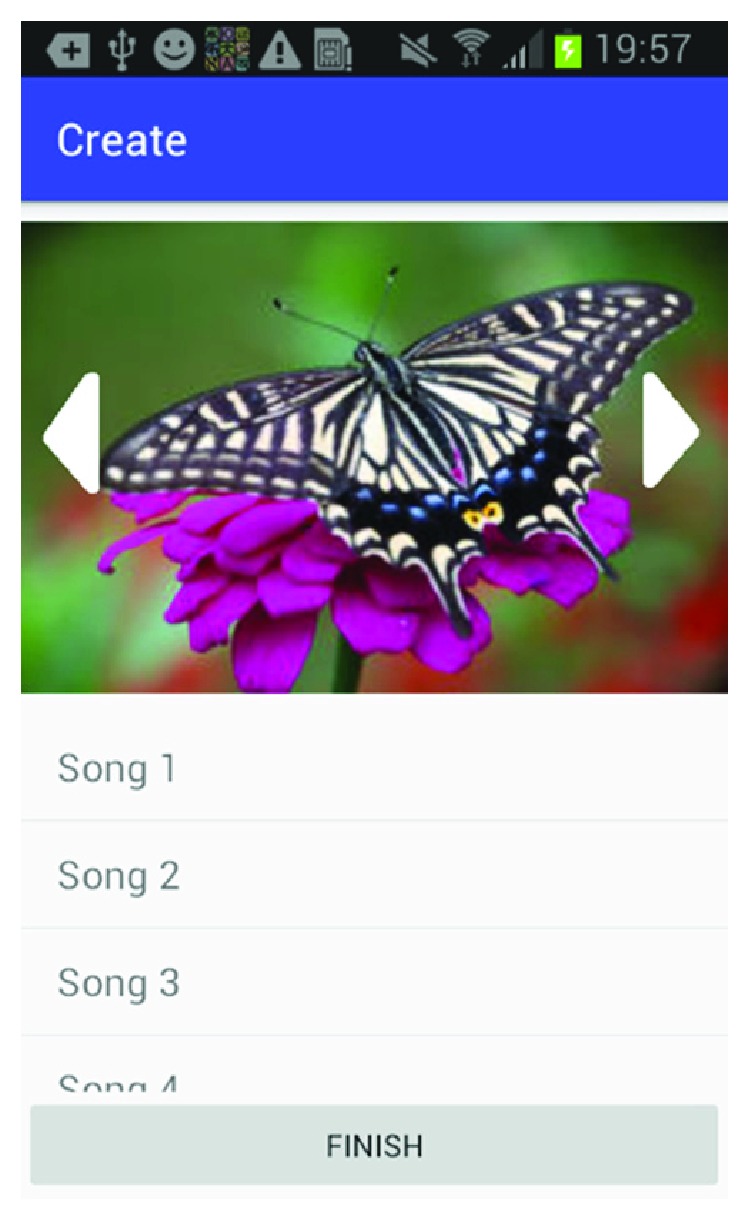
Music selection.